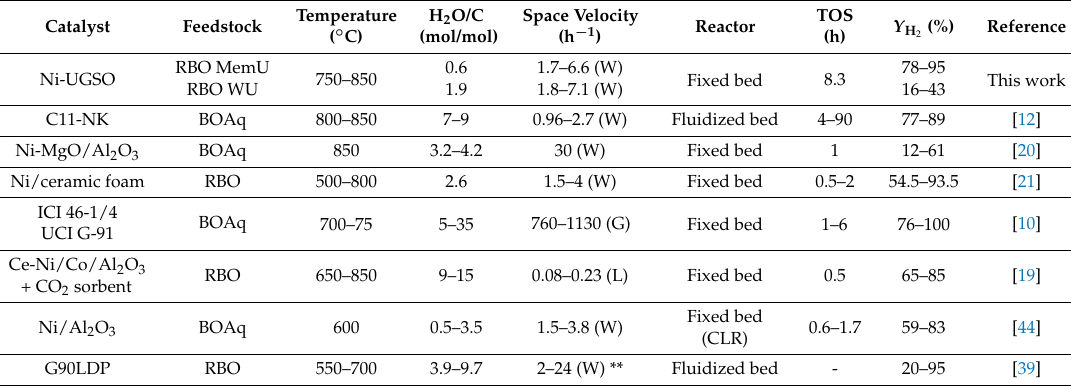
RBO: Raw Bio-Oil; BOAq: Bio-Oil Aqueous fraction; W: WHSV; L: LHSV; G: G C1 HSV; ** g volatiles /g cat